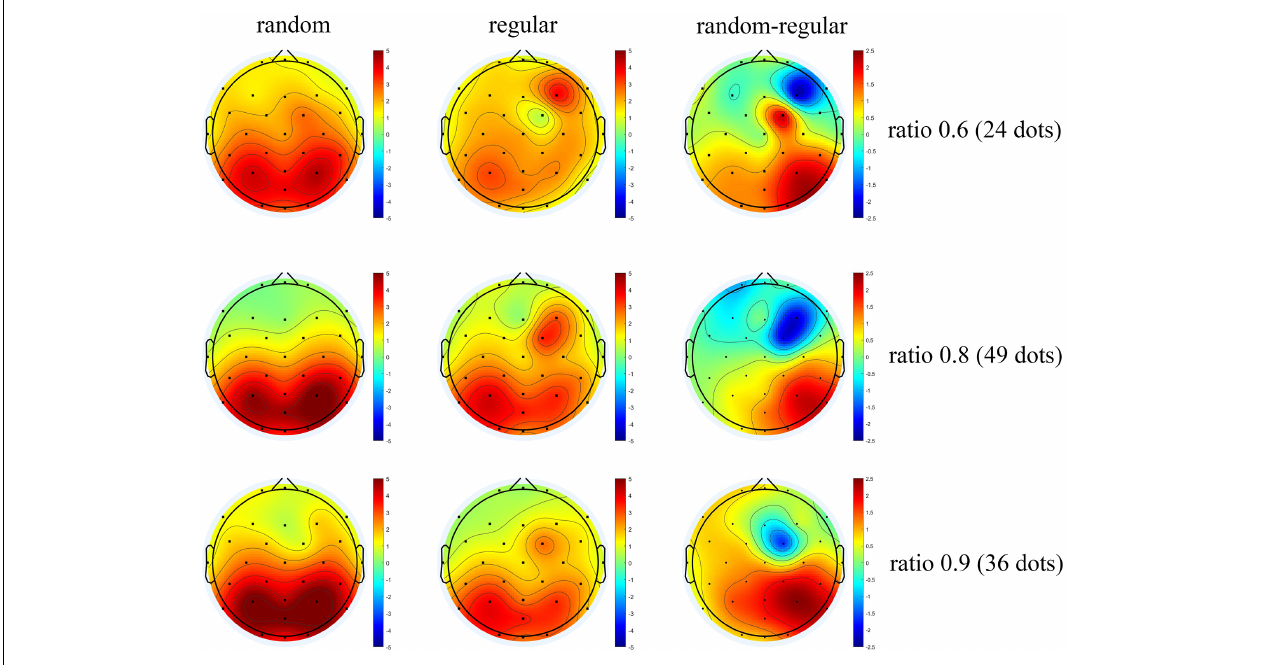
FIGURE 9 | The topographic distribution of average P2p. The average amplitude of ERP of participants from 200 to 250 ms after test presentation (P2p) is shown by the scalp topography. Graphs for randomly distributed patterns are in the left column, graphs for regularly distributed patterns are in the middle column, and the subtractions of the two are shown in the right column. The graphs are arranged according to the ratios between tests and references from the upper row to the lower